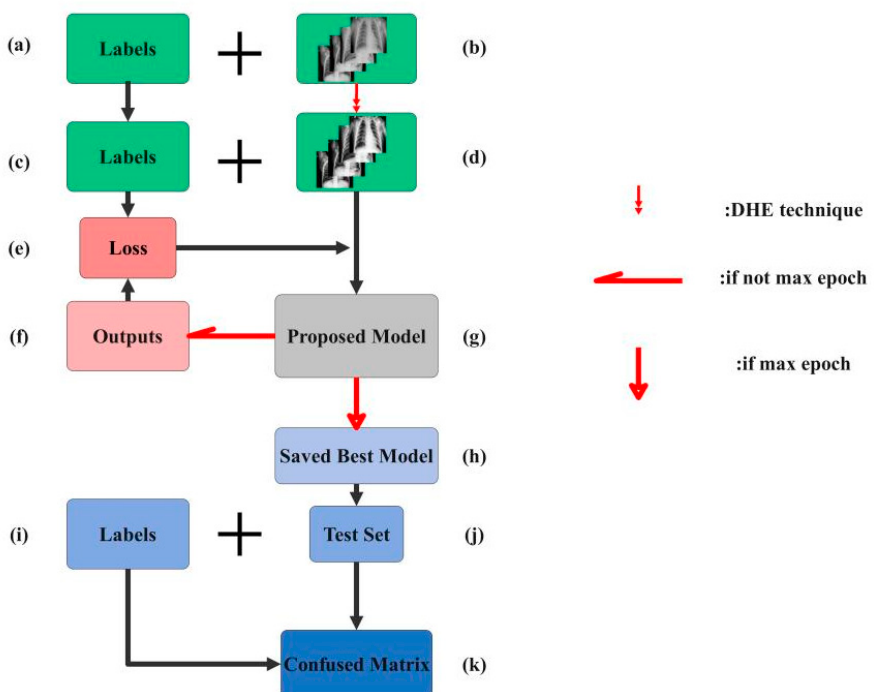
Figure 4. The workflow of our proposed Deep Learning architecture. ( a , c ) The labels of the training subset where 0 denotes the images that do not show pneumonia, while 1 denotes the images with pneumonia; ( b ) the original train subset and ( d ) the enhanced train subset processed by the DHE technique. ( e ) The loss used in this study; ( g ) is the DL model proposed; ( f ) is the outputs of the model where 0 denotes images without pneumonia while 1 denotes images showing pneumonia; ( h ) is the best model saved after training; ( j ) is the original test subset; ( i ) is the labels of the test subset where 0 denotes the images without pneumonia, while 1 denotes the images showing pneumonia; ( k ) is the confusion matrix to evaluate the performance of the model.